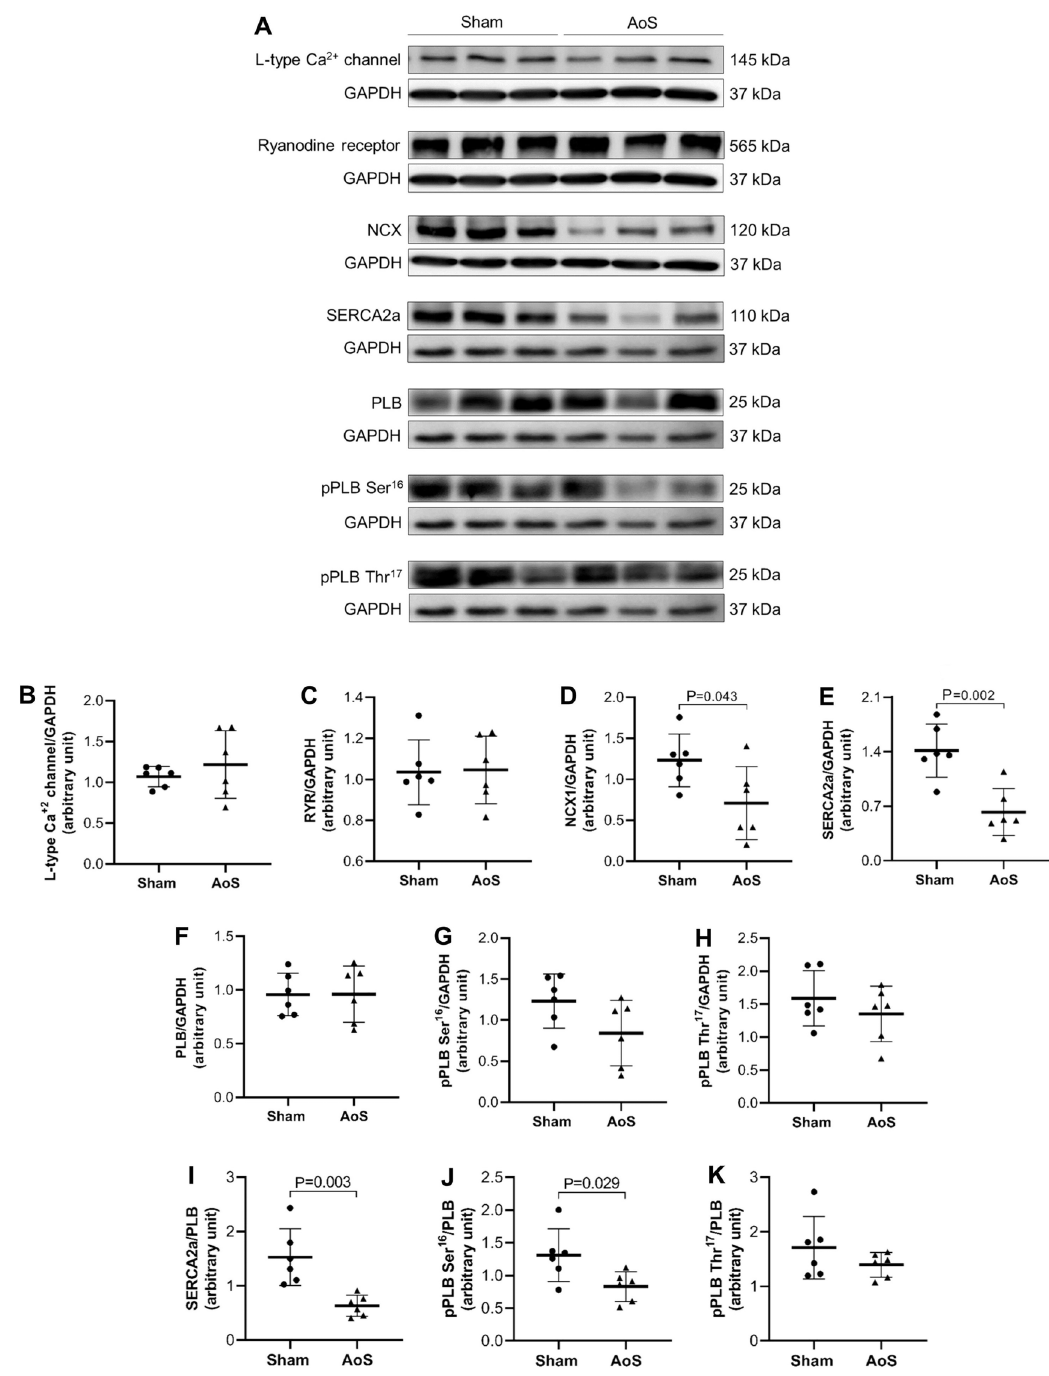
Figure 6. Western blot analysis of intracellular Ca 2 + -cycling proteins in myocardium from Sham and aortic stenosis (AoS) rats (n=6 in each group). A, Representative bands of the proteins. Quanti fi cation of myocardial ( B ) L-Type Ca 2 + channel, ( C ) ryanodine receptor (RyR), ( D ) Na + /Ca 2 + exchanger (NCX1), ( E ) sarcoplasmic reticulum calcium-ATPase (SERCA2a), ( F ) total phospholamban (PLB), ( G ) phosphorylated PLB on serine-16 (pPLB Ser16), and ( H ) phosphorylated PLB on threonine-17 (pPLB Thr17) normalized to glyceraldehyde 3-phosphate dehydrogenase (GAPDH). Quanti fi cation of ( I ) SERCA2a, ( J ) pPLB Ser16, and ( K ) pPLB Thr17 normalized to total PLB. Data are reported as means ± SD. P o 0.05, Student ’ s t